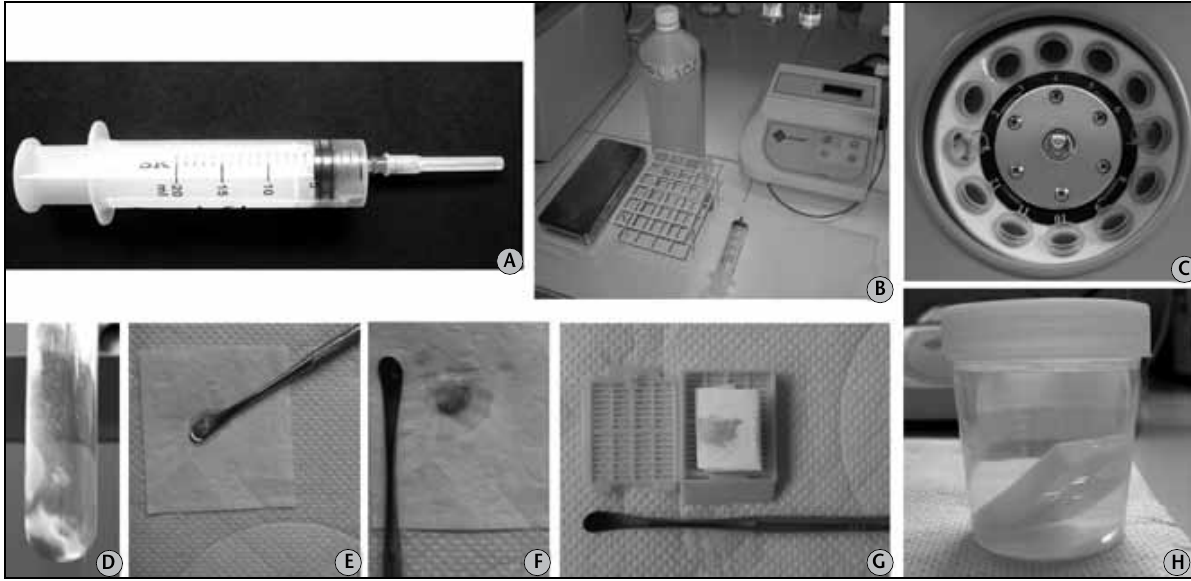
Figura 2 – Procedimentos laboratoriais da técnica de cell block